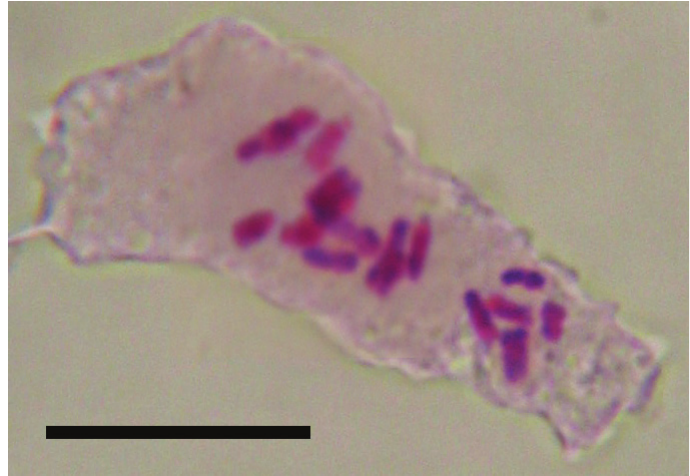
Figure 1. Centaurea aspromontana Brullo, Scelsi & Spamp., 2 n = 18. Scale bar: 10